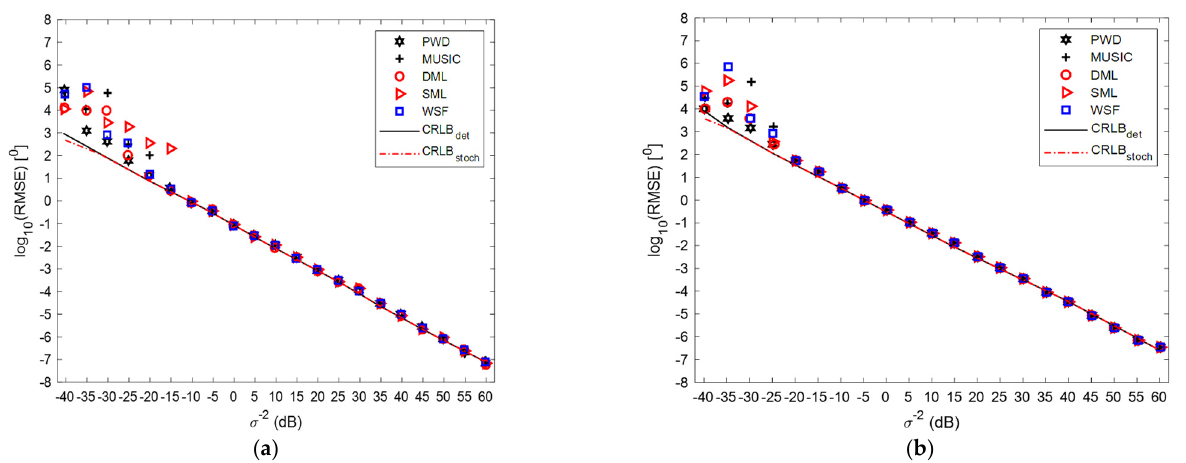
Figure 3. Root-mean-square error over CRLB and 100 Monte Carlo samples: ( a ) elevation and ( b ) azimuth angle versus noise variance σ − 2 for a single signal in φ = θ = 60 ◦ . The azimuth angle has a larger CRLB and RMSE than the elevation angle. ( a ) ˆ θ , elevation ( b ) ˆ φ ,